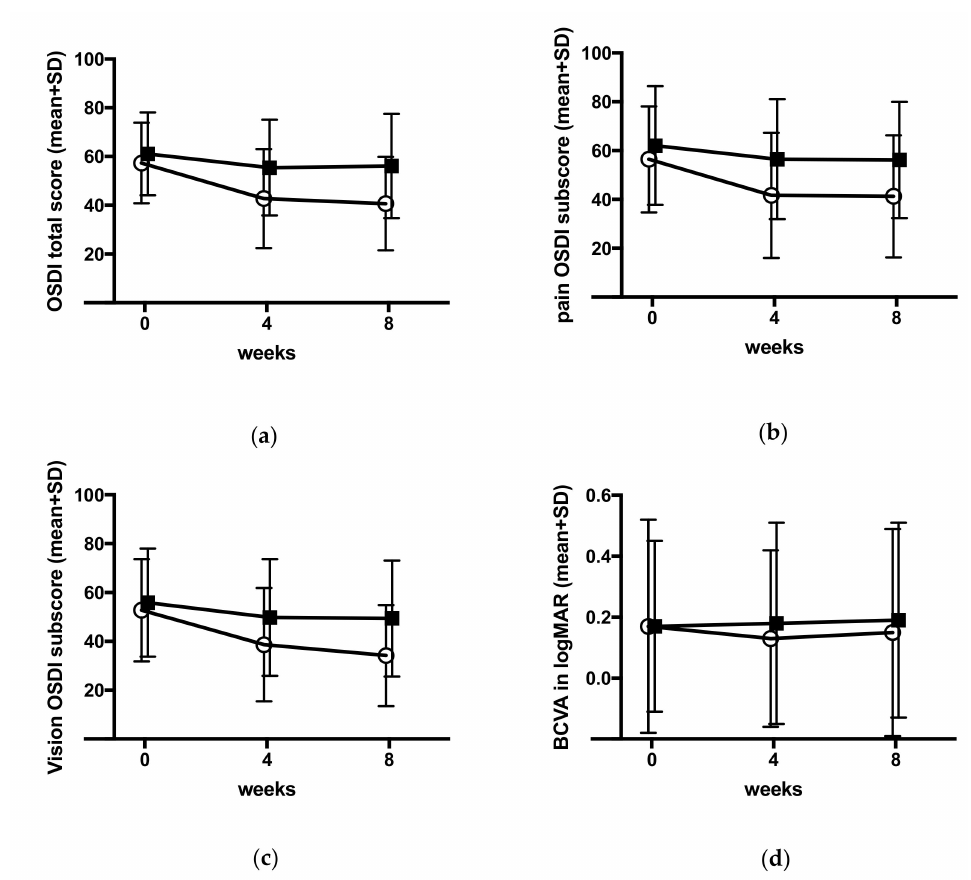
Figure 3. ( a ) Mean ( ± SD) OSDI total score; ( b ) mean ( ± SD) OSDI pain subscore; ( c ) mean ( ± SD) OSDI vision subscore; ( d ) mean ( ± SD) best corrected visual acuity (BCVA). Open circles = Comfort Shield group, filled squares = control